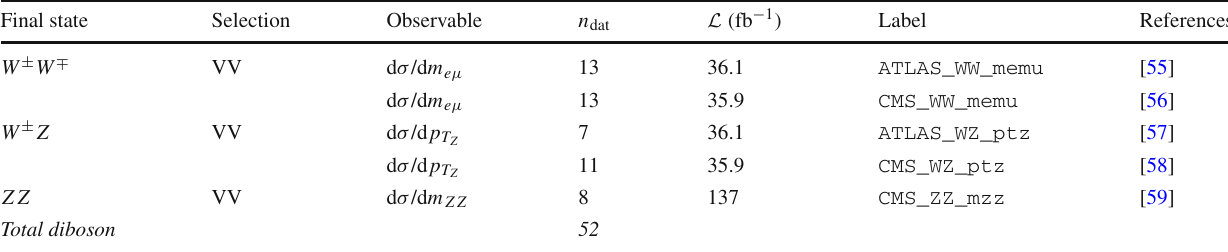
Table 6 Overview of the diboson measurements considered in this